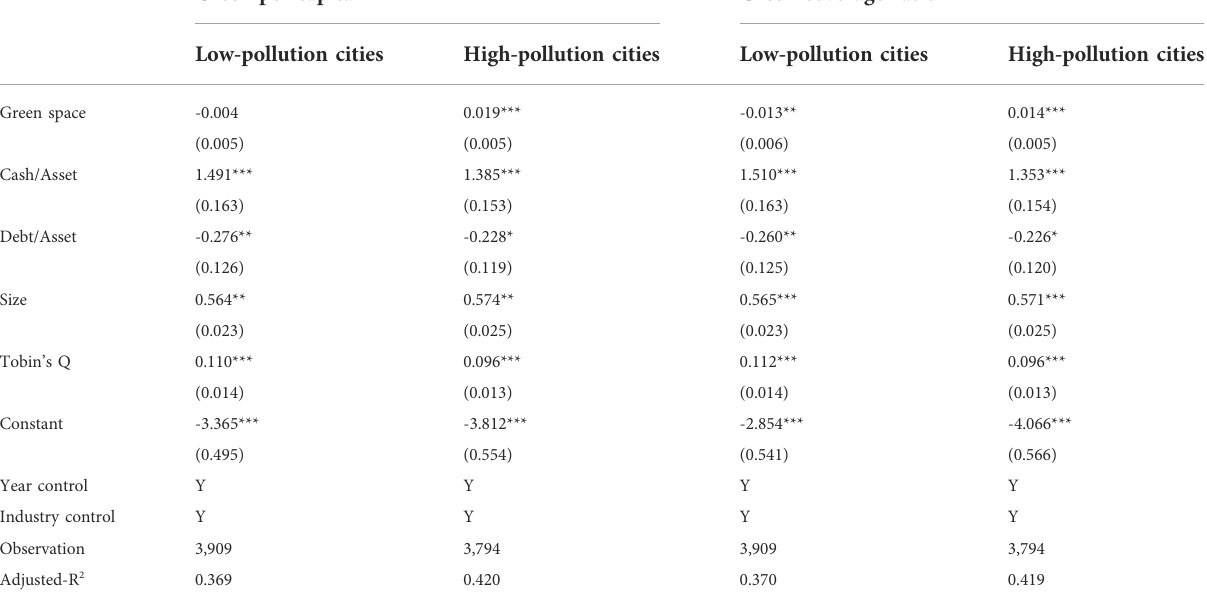
TABLE 9 Heterogeneity analysis based on air